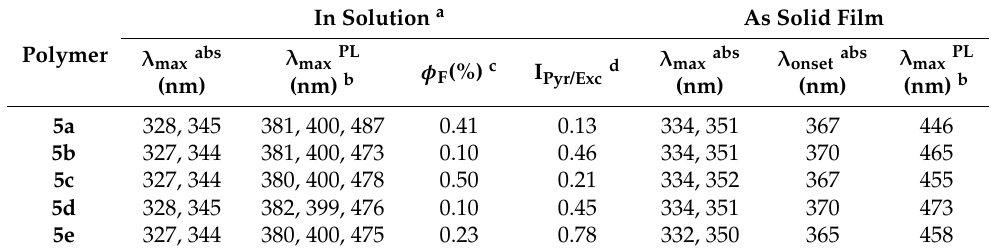
Table 3. Photophysical behaviors of